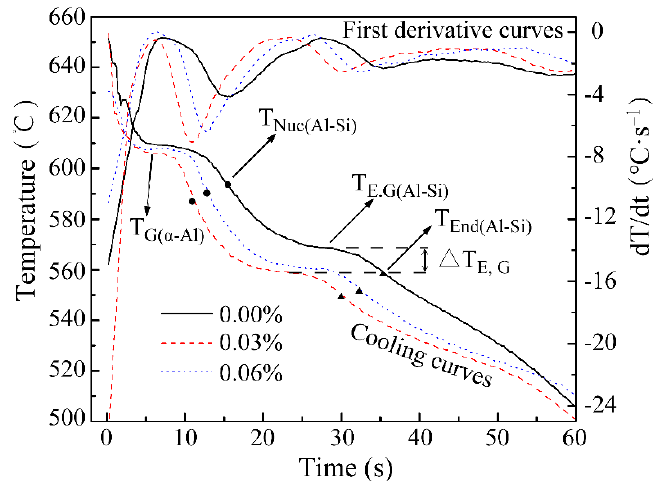
Figure 3. Cooling curves and their first derivative curves of A356 alloy unmodified and modified with 0.03wt.% and 0.06wt.% Sr, respectively.